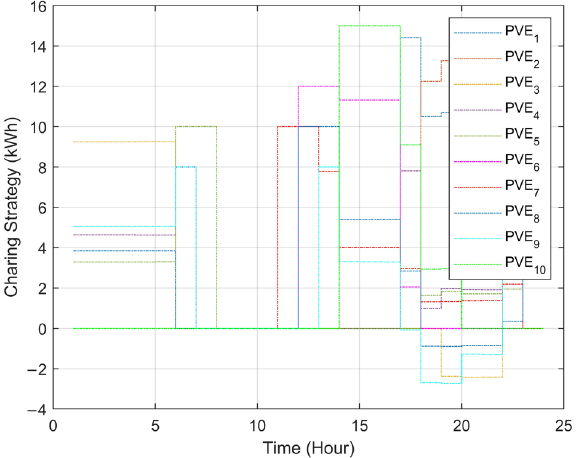
Figure 2. Convergence performance of AD-GEED.